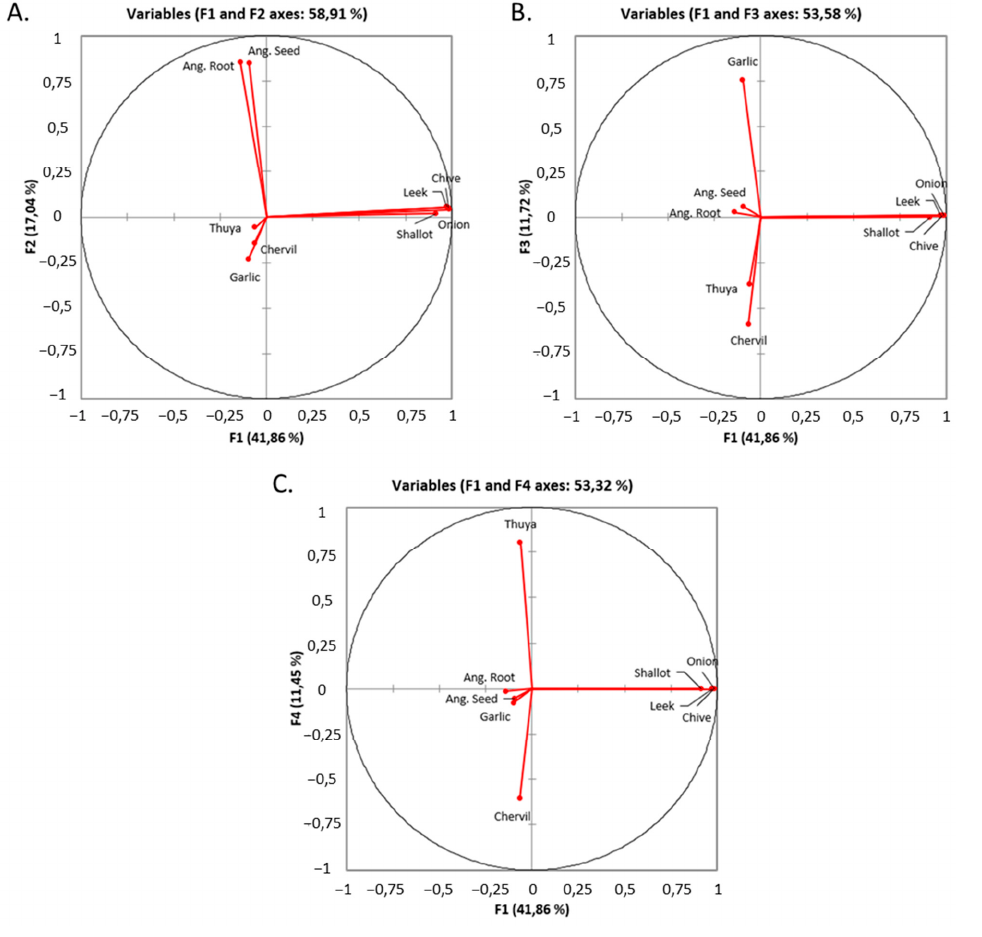
Figure 1. Correlation circles from the principal component statistical analyses (PCA) on the 9 tested essential oils (EO), with projections on F1 and F2 axes ( A ), on F1 and F3 axes ( B ) and on F1 and F4 axes ( C ).